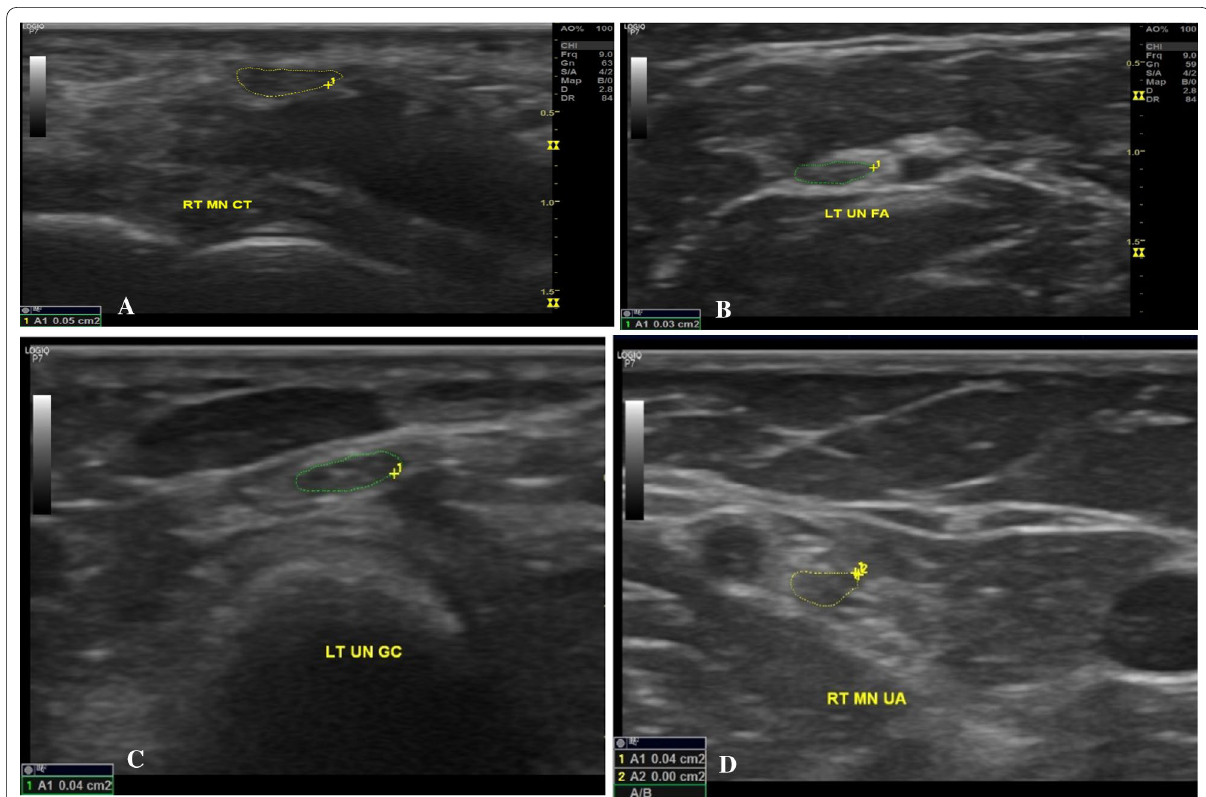
Fig. 7 Showing ultrasound image of median and ulnar nerves in different levels denoting atrophy in ALS patients. A Right median nerve in carpal tunnel. B Left ulnar nerve in forearm. C Left ulnar nerve in Guyon’s canal. D Right median nerve in upper